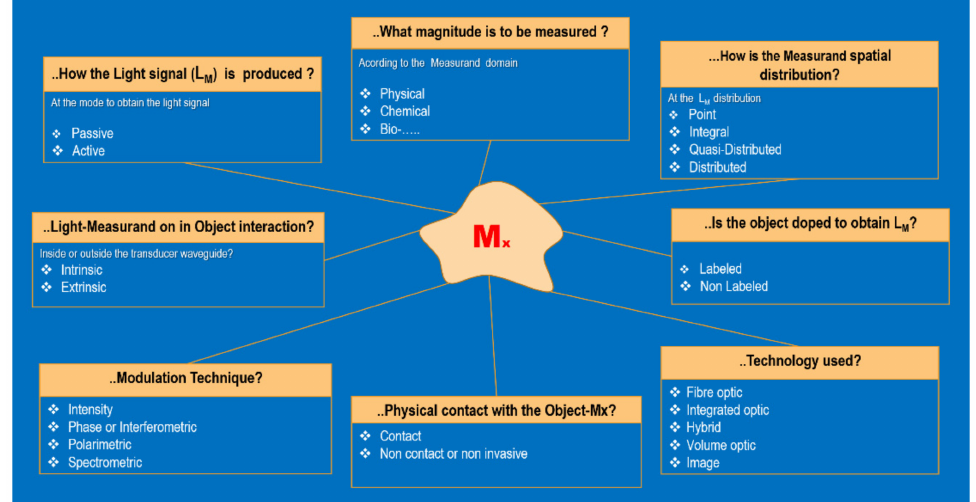
Figure 5. Types of photonic sensors taking into consideration aspects concerning the measurand (Mx) on/in the object (Oy) and the modulated Light (LM). Courtesy of the